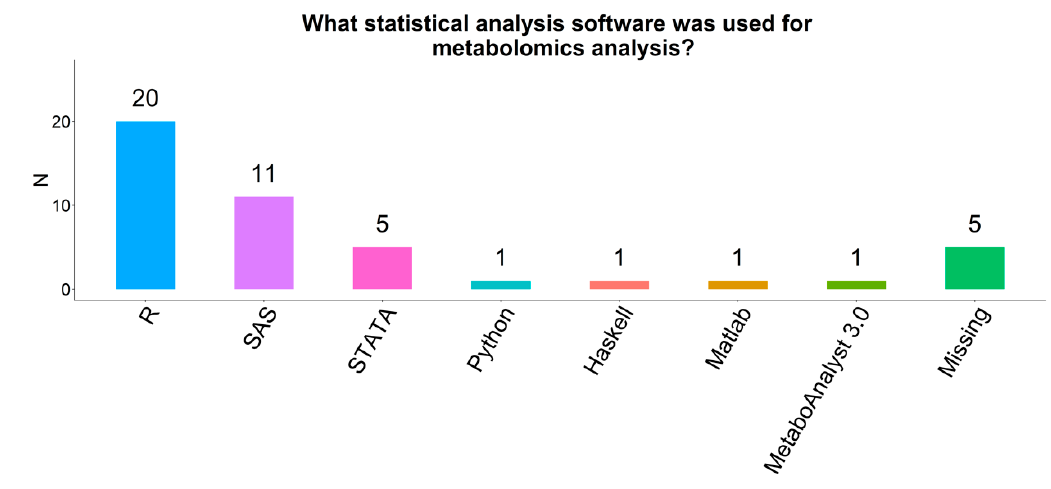
Figure 8. Statistical analysis software used by participating COMETS cohorts.